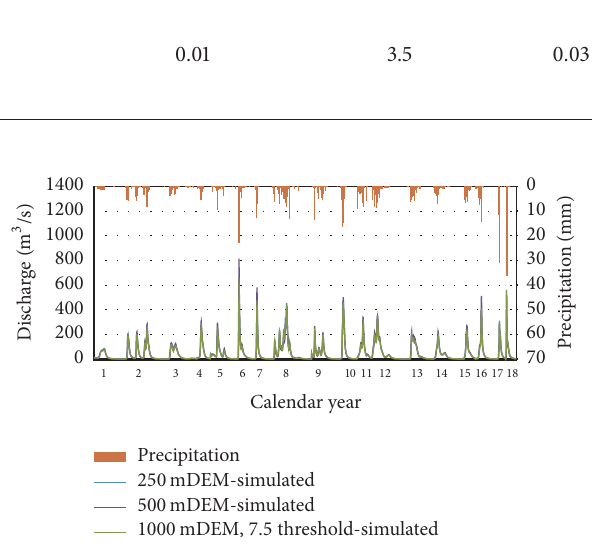
Figure 5: Comparison of the results under the DEM resolution of 250 m, 500m, and 1000 m.